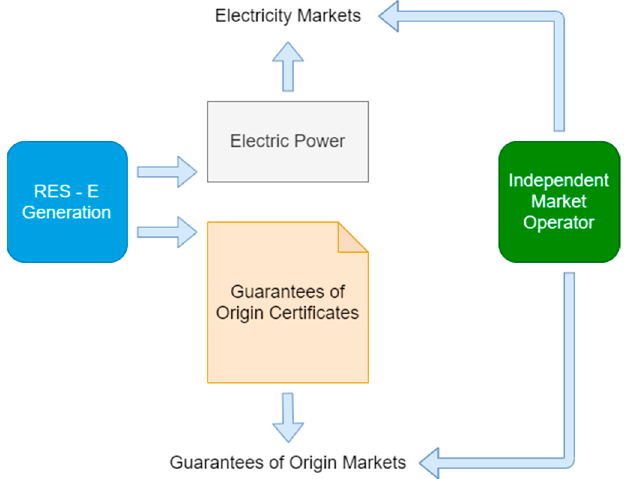
Figure 1. Electric Energy Market and Guarantees of Origin Market, adapted from [14].